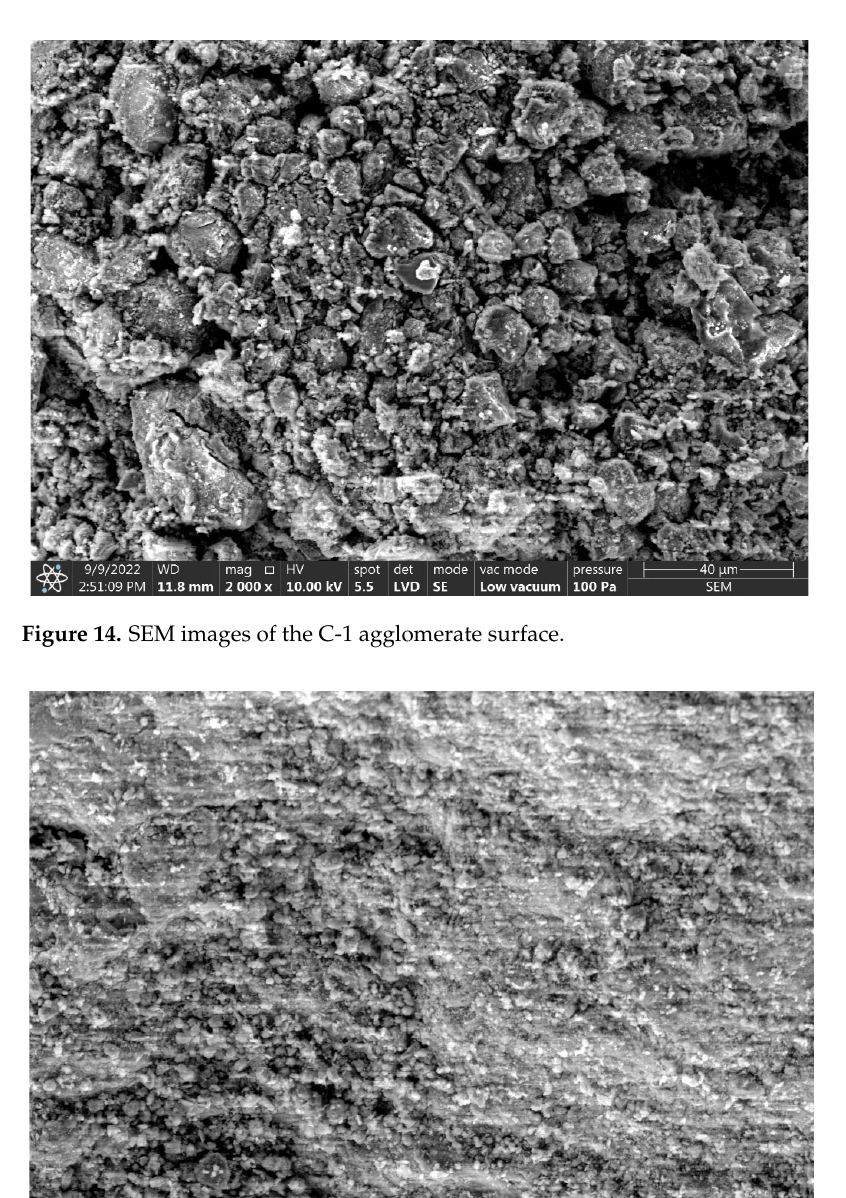
Figure 16. SEM images of the commercial sorbent (diatom shell in the center). Comparing the microstructure of the produced sorbents and the commercial sorbent, it can be concluded that the surface of the Ukrainian dust granules is more developed. The surface of the Slovak dust granules and the commercial sorbent is similar and less developed. In addition, SEM observations of the microstructure of the commercial sorbent identified remnants of diatom carapaces (Figure 16). The efficiency (Figure 17) of the agglomeration process using the two ‐ stage method for all samples is very similar and averages 50%, only in the case of clinoptilolite dust from Ukraine with binder A, the efficiency of the process is slightly lower at 45%, while for the same binder used to agglomerate clinoptilolite dust from Slovakia, the efficiency of the process is already 50%. The best agglomeration process efficiency was found when binder B was used and is 56% and 53% for dust from Slovakia and Ukraine, respectively.